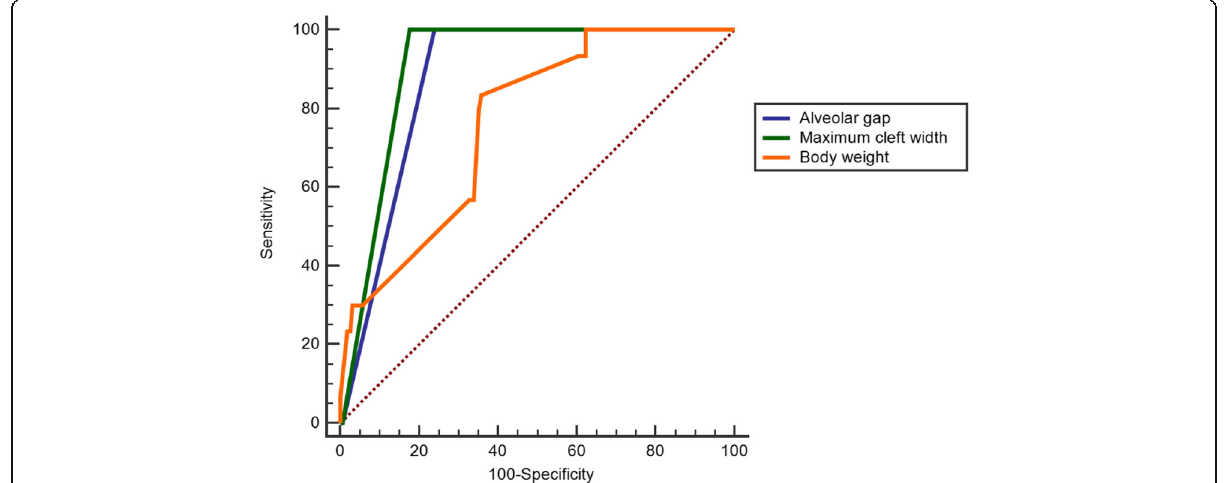
Fig. 4 ROC curve for the performance of alveolar gap, maximum cleft width, and body weight in prediction of difficulty of